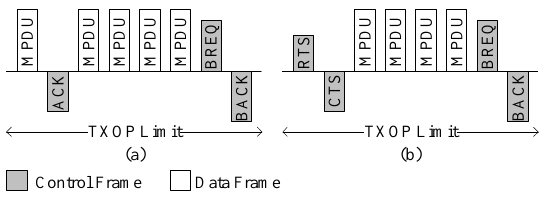
Figure 1. IEEE 802.11e block ACK in ( a ) basic access mode and ( b ) RTS/CTS access mode.